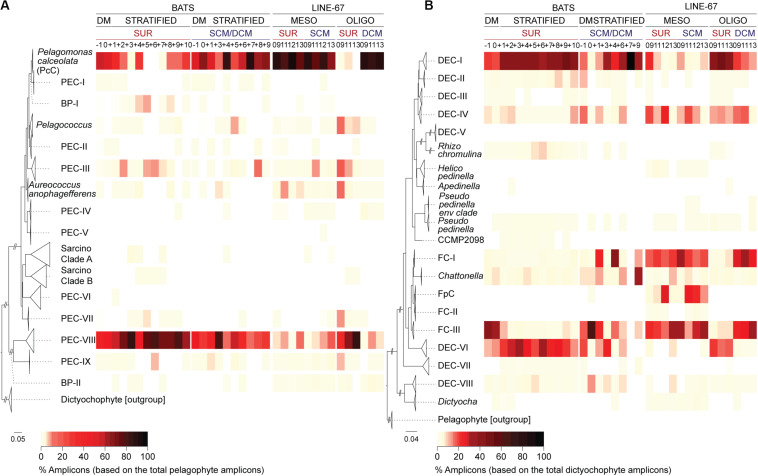
Diversity and distributions of newly resolved dictyochophyte and pelagophyte clades at BATS and in the ENP. High-taxonomic resolution of (A) pelagophyte and (B) dictyochophyte distributions at the surface (SUR) and depth (SCM/DCM) at BATS and ENP. Reference trees to the left of each panel indicate clades. Heatmaps show the percentage of amplicons relative to those of pelagophytes (A) and dictyochophytes (B) during each BATS month or ENP samples (vertical columns; see Figure 4 for additional details on ENP samples). Bootstrap support and phylogenetic inferences are as detailed in Figure 2B and Supplementary Figure S5. ENP samples are partitioned based on standing stock nutrient concentrations which were considered mesotrophic (MESO) or oligotrophic (OLIGO) (Supplementary Table S5).